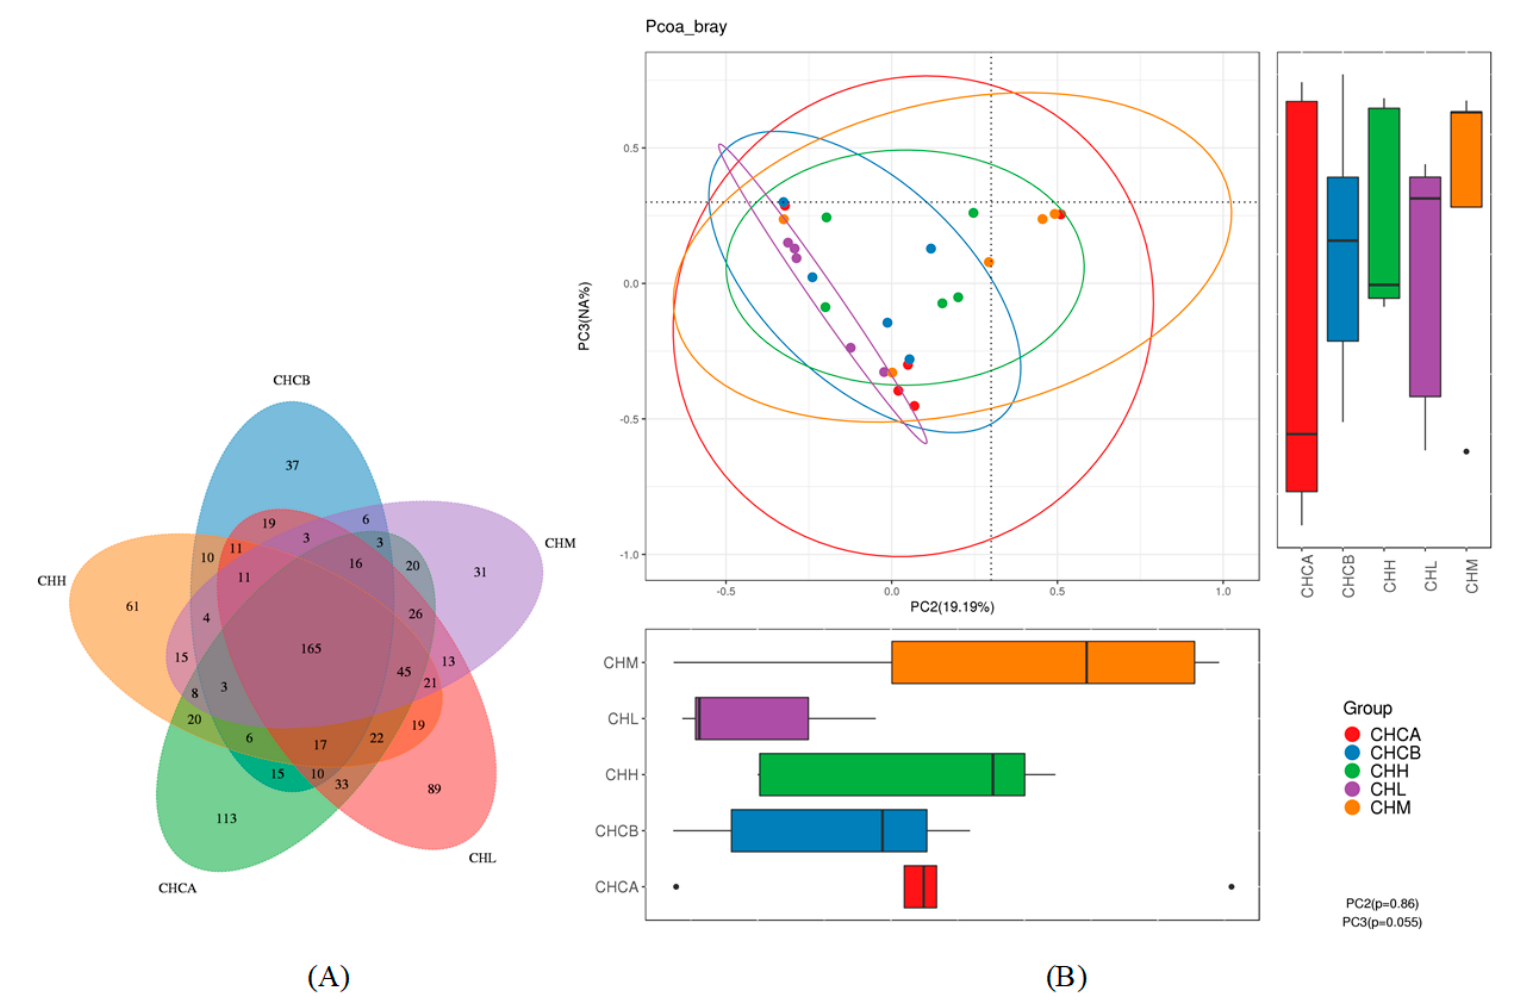
Figure 3. Effects of capsaicin and CIF on the richness and diversity of the gut microbiota. ( A ): Venn diagram of the number of OTUs of intestinal contents between experimental and control groups. ( B ): principal coordinate analysis (PCoA) of intestinal flora structure of mice in experimental and control groups.